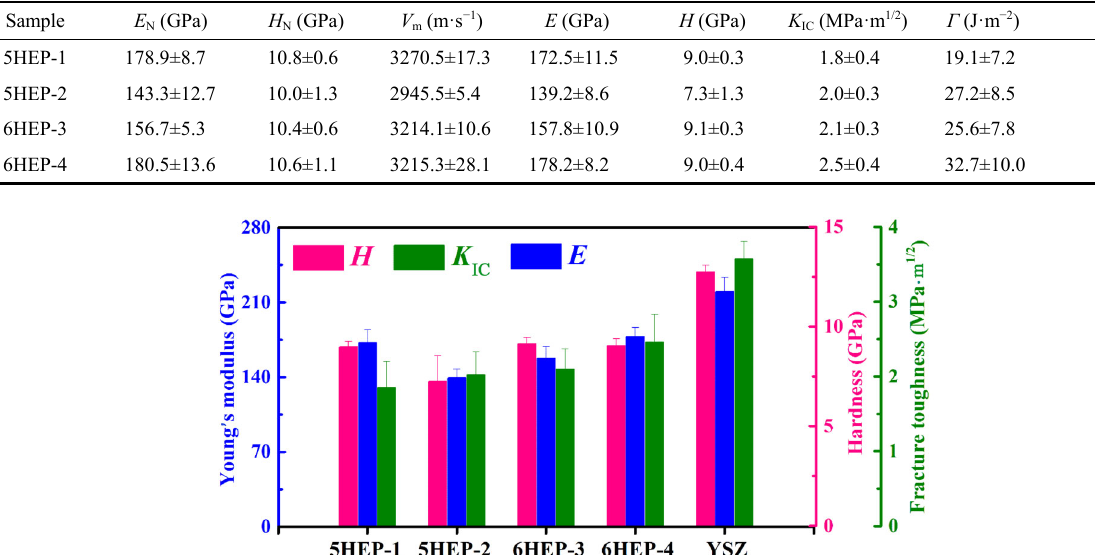
Table 2 Young’s modulus and nano-Young’s modulus ( E and E N ), hardness and nano-hardness ( H and H N ), fracture toughness ( K IC ), mean acoustic velocity ( V m ), surface fracture energy ( Γ ), and G / B ratio of HEP RETa 3 O 9 ceramics